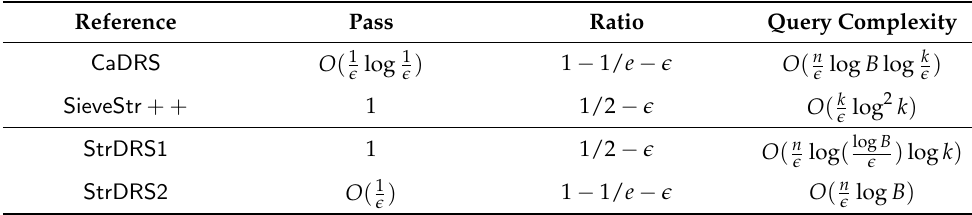
Table 1. State-of-the-art algorithms for the problem of monotone DR-submodular function maximiza- tion with a cardinality constraint on the integer lattice in terms of time